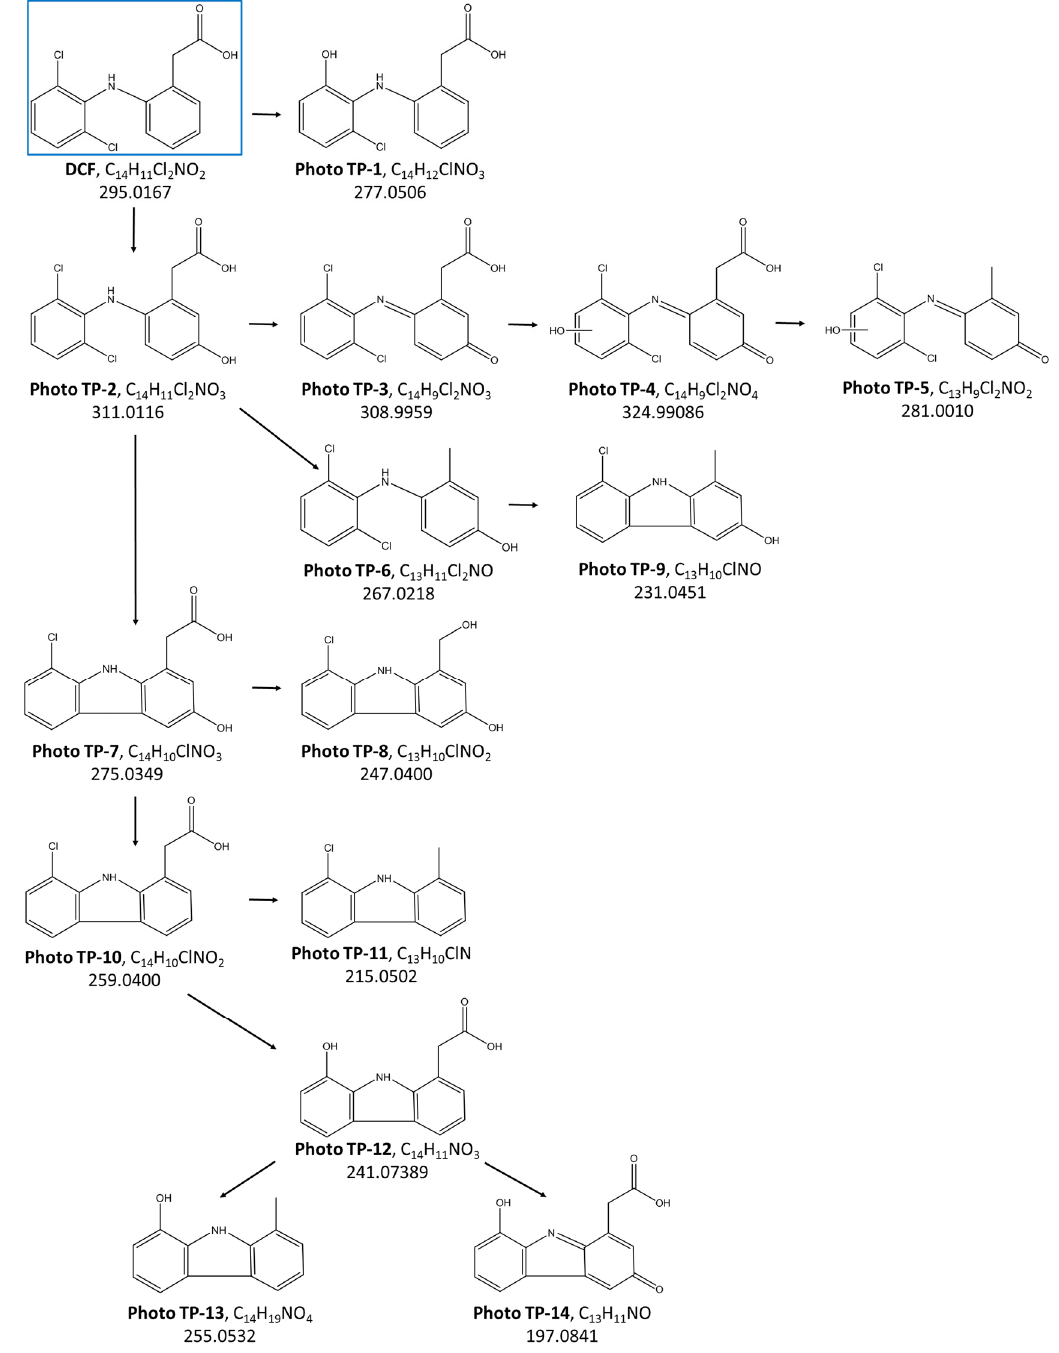
Figure 2. DCF degradation pathway proposed for the Photo TPs identified during treatment with HApTi.